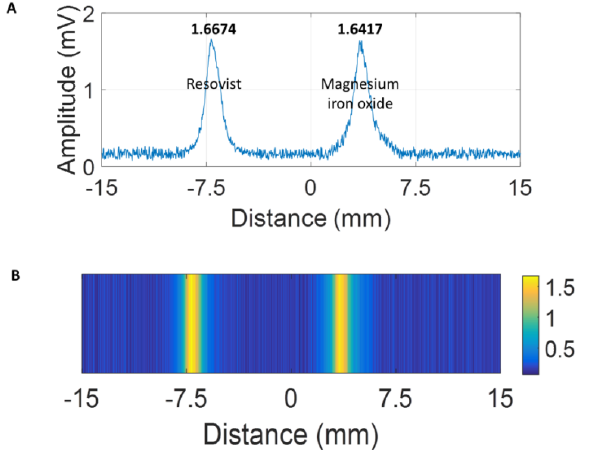
Figure 6. ( A ) Signals and ( B ) magnetic particle imaging (MPI) images of RES NPs and MgIONPs@TMAH.